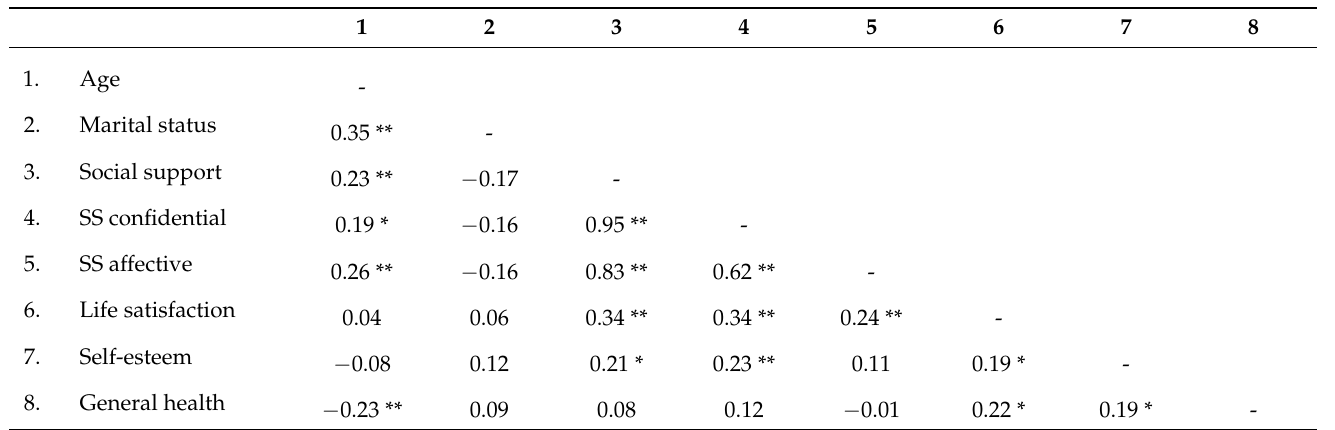
Table 2. Correlations between the study variables.